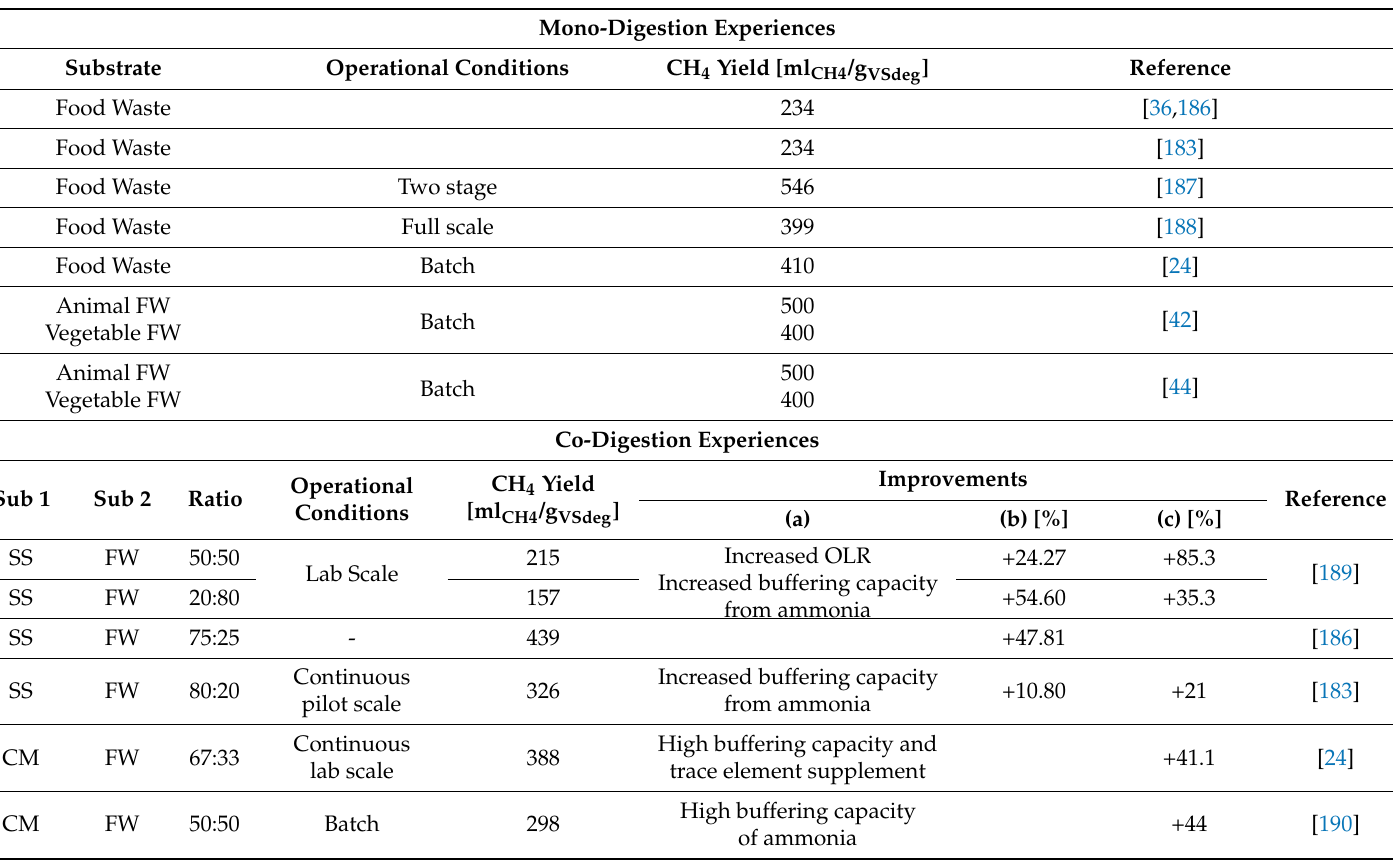
Table 3. Food waste (FW) biodegradability through anaerobic mono-digestion and co-digestion